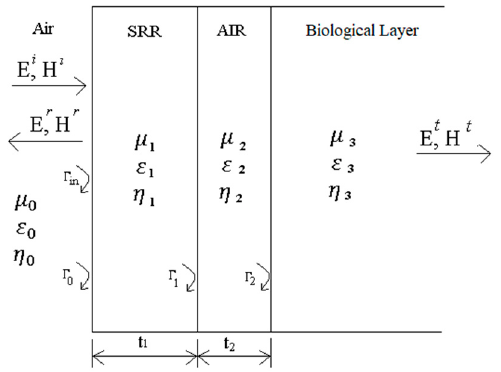
Figure 1. Scheme of the normal wave propagation through the two layers sandwiched between two semi-infinite media. The split ring resonator (SRR) metamaterial layer is placed to distance t 2 from the medium to be matched.